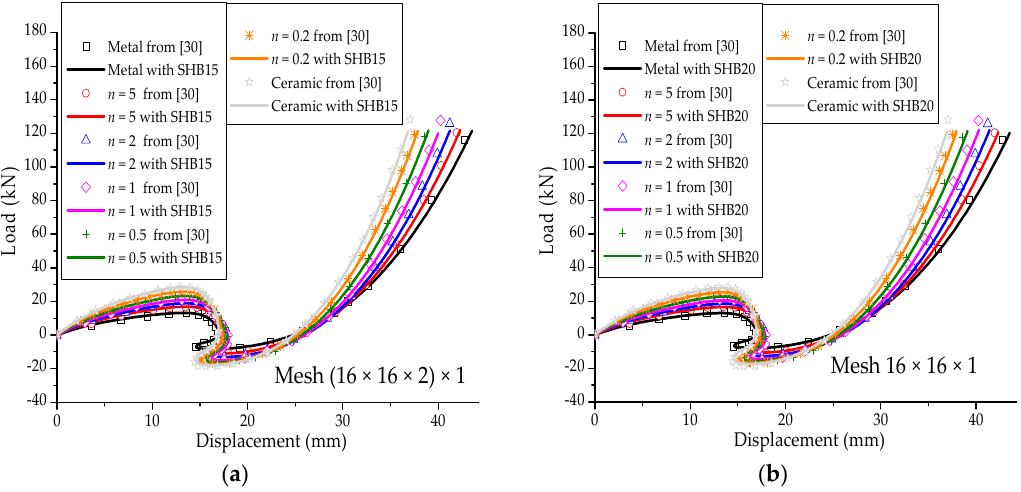
Figure 13. Deflection at the central point A under concentrated force for the thin hinged roof. ( a ) prismatic SHB15 element; ( b ) hexahedral SHB20 element.